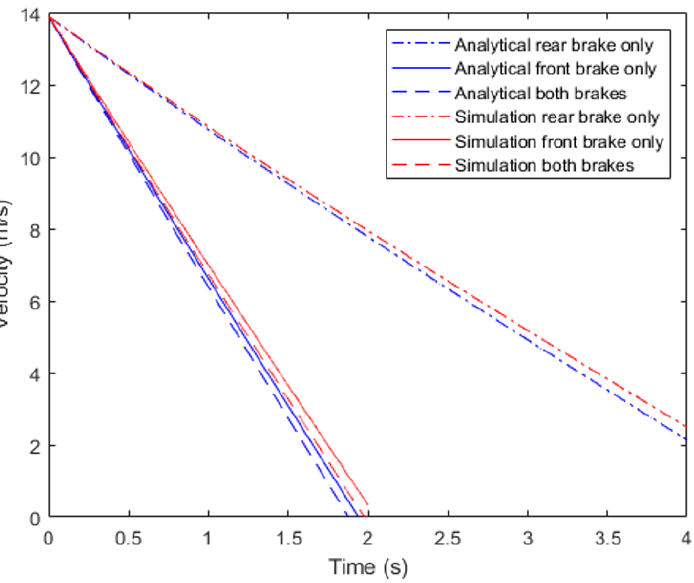
Figure 4. Stopping distance velocity profiles for front, rear, and both brake applications comparing analytical results to simulated results.